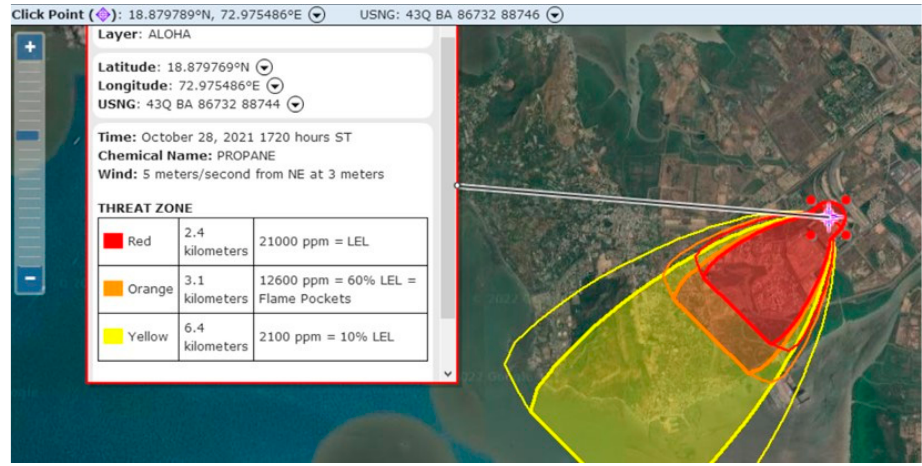
Figure 9. Risk mapping results of vapour cloud explosion for scenario S13 (catastrophic rupture of Horton sphere).